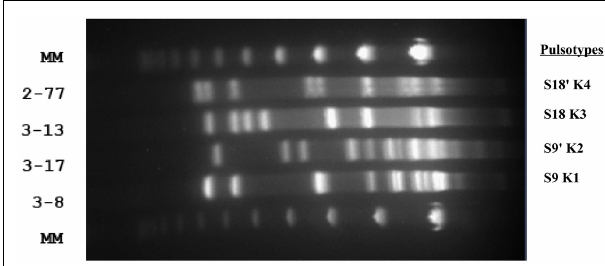
FIGUREA2 | Pulse field gel electrophoresis after Kpn I digestion on four C. jejuni isolates. Two pairs of isolates (3-8 and 3-17, 3-13 and 2-77) displayed very similar Sma I PFGE profiles (S9 and S9 (cid:2) , S18 and S18 (cid:2) respectively), and were consequently submitted to PFGE after Kpn I digestion for discrimination.The picture shows four distinct Kpn I digestion profiles after PFGE (K1, K2, K3, and K4